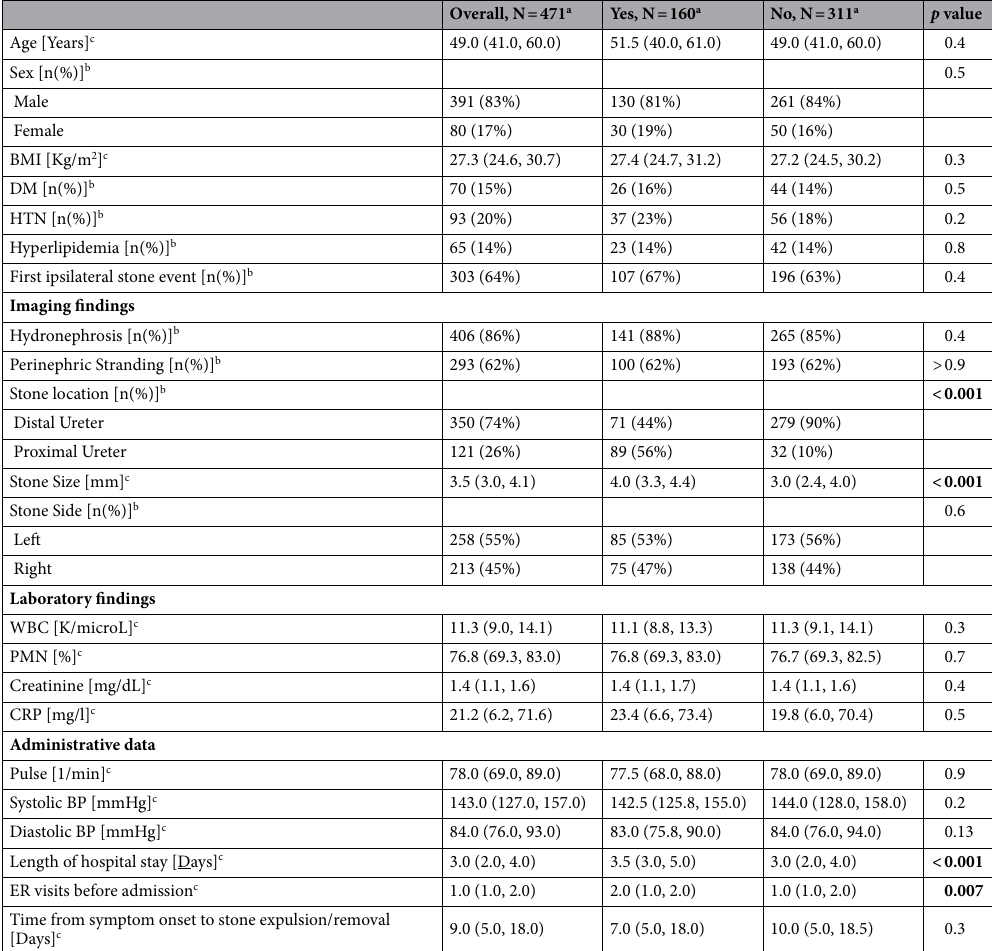
Table 1. Demographics and clinical features. a Median (IQR); n (%). b Categorical variable, Fisher exact test. c Continuous variable, Wilcoxon rank sum test. Bold indicates significant. Yes = Surgically Treated; No = Conservative